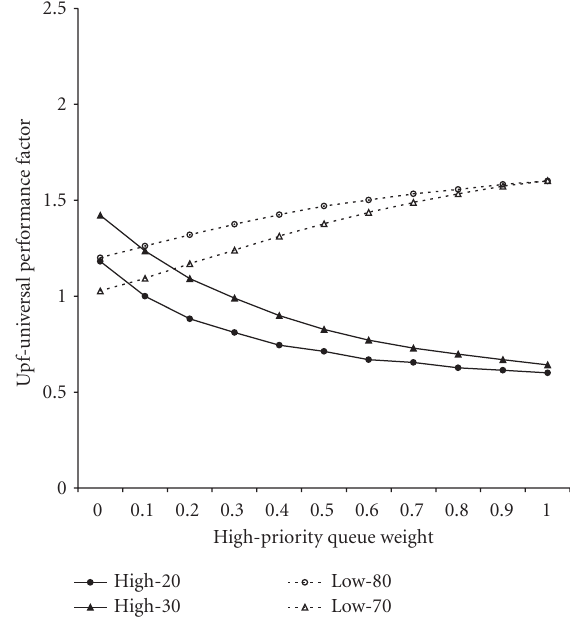
Figure 11: Universal performance factor for di ff erent priority classes under varying high-priority queue weights and high